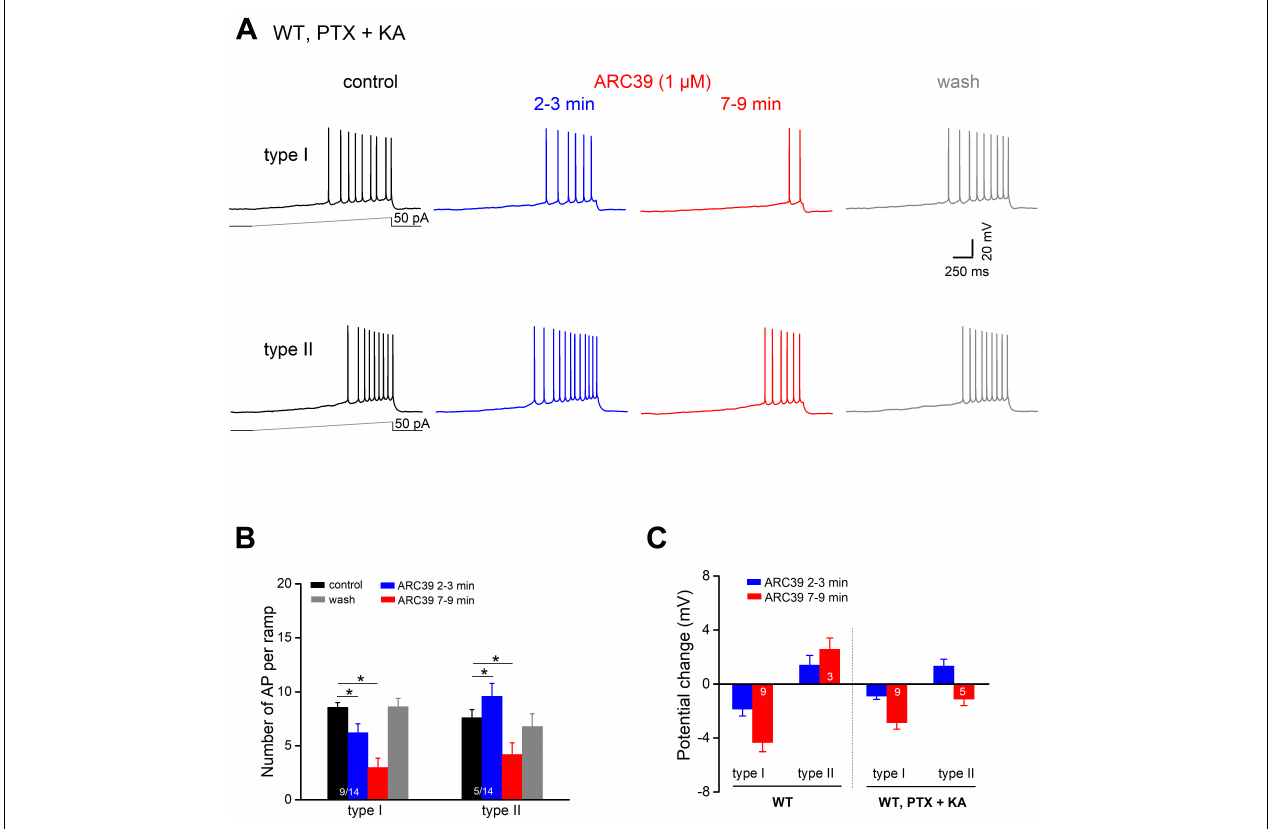
FIGURE 5 | ARC39 attenuates intrinsic firing properties of CA1 pyramidal cells. All current-clamp recordings were performed in wt cells, which were pharmacologically isolated from GABAergic and glutamatergic synaptic inputs by PTX (100 µ M) and KA (2 mM), respectively. (A) Recordings from two CA1 pyramidal cells showing the two types of responses to ARC39 (1 µ M). Type I was characterized by gradual decline in firing during drug application, whereas type II displayed an early transient increase in firing before the reduction set in. (B,C) Histograms summarize the divergent effect of ARC39 on AP firing (B) and concurrent change in membrane potential (C) , sub-grouped according to their earlier response. The corresponding recordings from wt cells obtained in the absence of PTX and KA were included in panel (C) (left-hand side) for comparison. * p < 0.05.